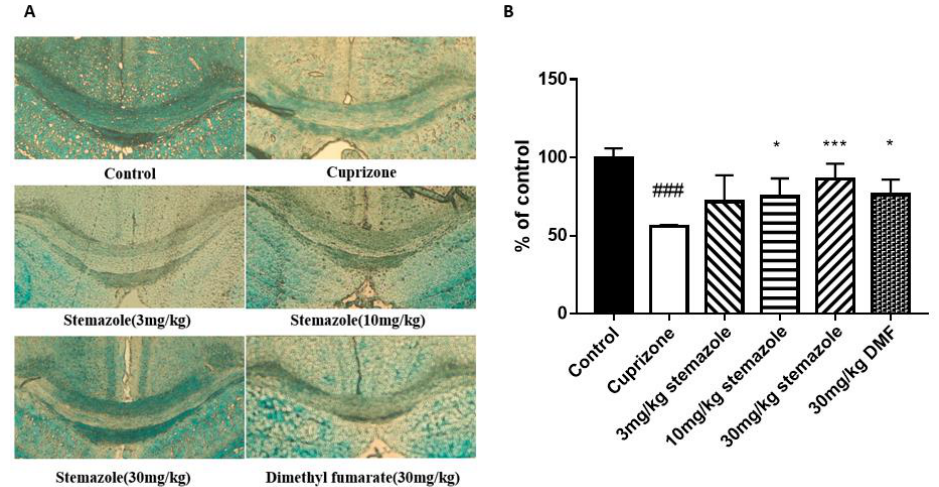
Figure 5. The protective effect of stemazole on myelin in corpus callosum (cc) demyelinating lesions was observed by LFB staining. ( A ) LFB staining was employed to evaluate the severity of demyelination. ( B ) Myelin densities were compared with those of the control and expressed as a percentage of the control value using ImageJ software. Data represent the means ± SD ( n = 5 duplicates). * p < 0.05, *** p < 0.001 vs. the CPZ group. ### p < 0.001 vs. control group.